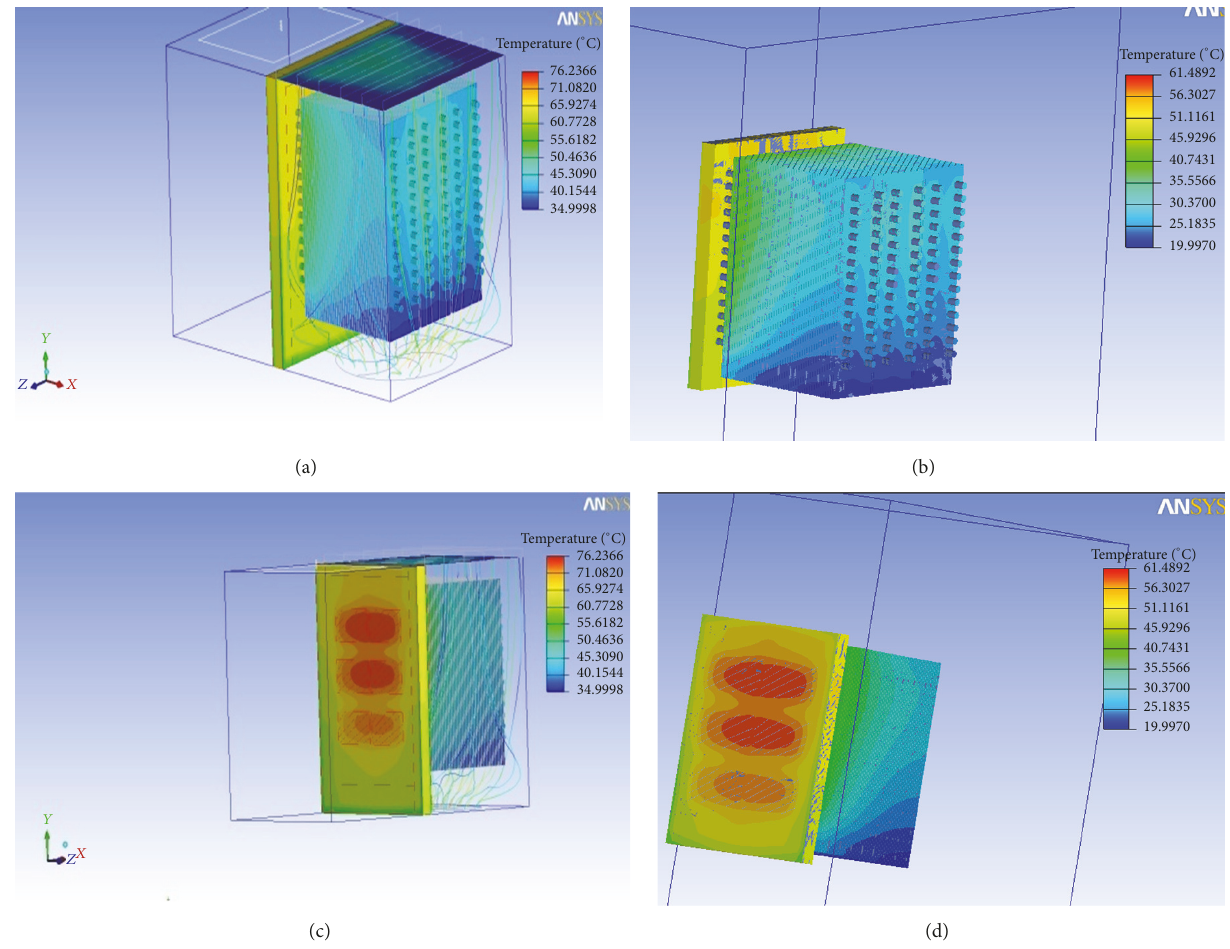
Figure 10: Thermal analysis comparison between the two equivalent modes. (a) Temperature rise of heatsink based on simplified SVPWM; (b) temperature rise of heatsink based on quasi-square-wave modulation; (c) temperature rise of substrate based on simplified SVPWM; (d) temperature rise of substrate based on quasi-square-wave modulation.